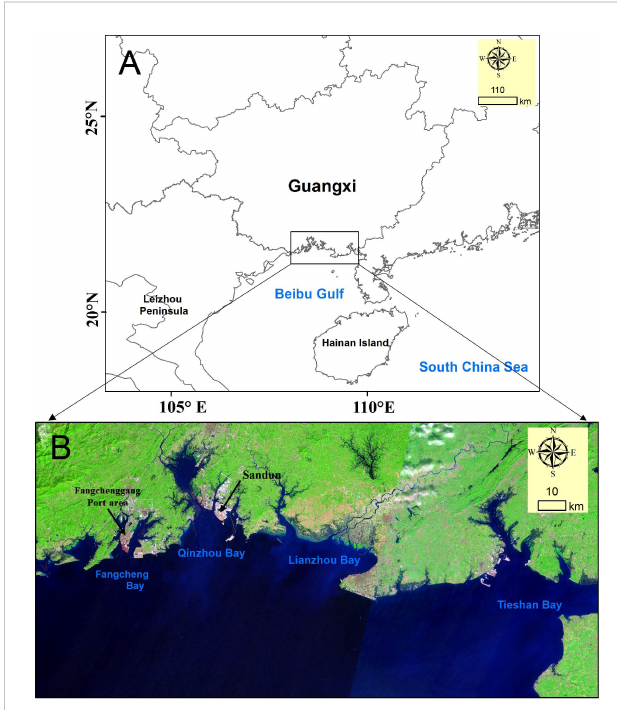
FIGURE 1 Map showing the location of the study area (A) . The main bays and two reclamation projects (B) are noted on Landsat images (captured on 22 Oct